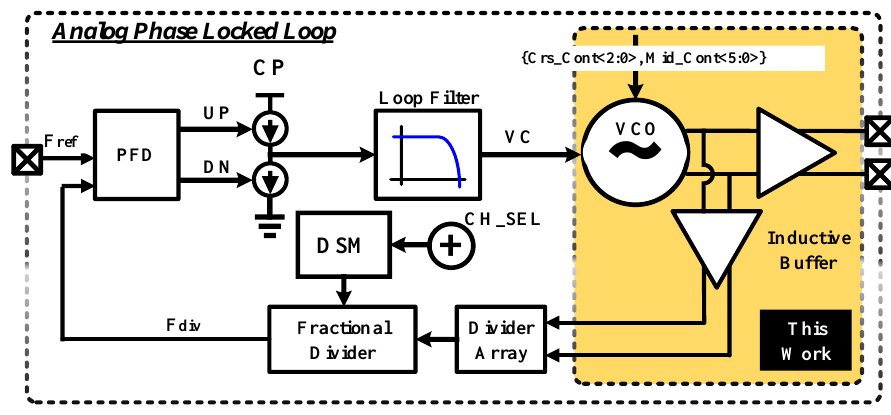
Figure 2. Top block diagram of an analog Phase-Locked Loops (PLL).